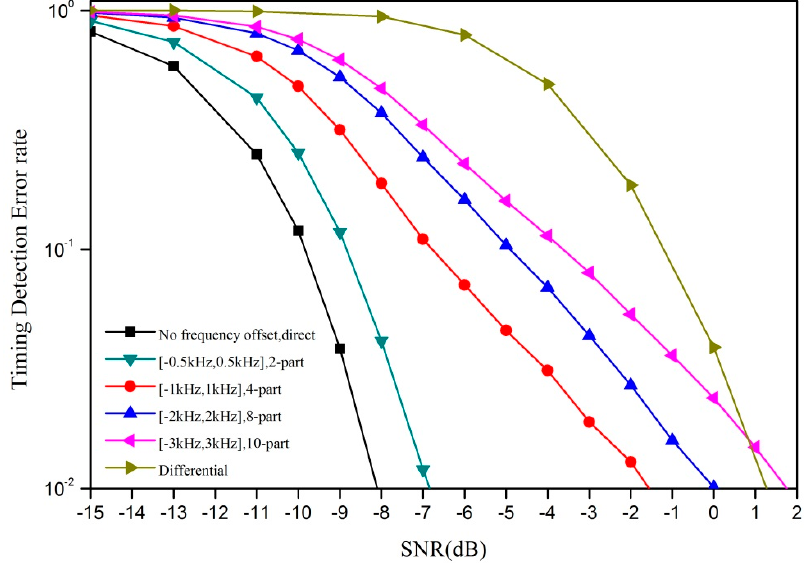
Figure 5. Timing detection error rate of the M-part correlator and the differential correlator with different frequency offsets.